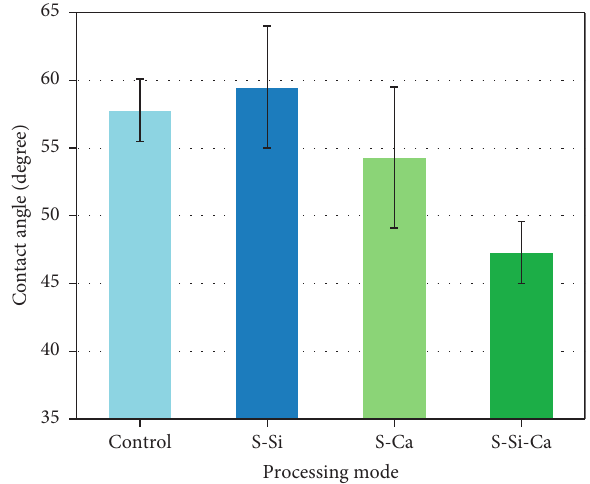
Figure 10: Contact angles between emulsified asphalt and RAP with different